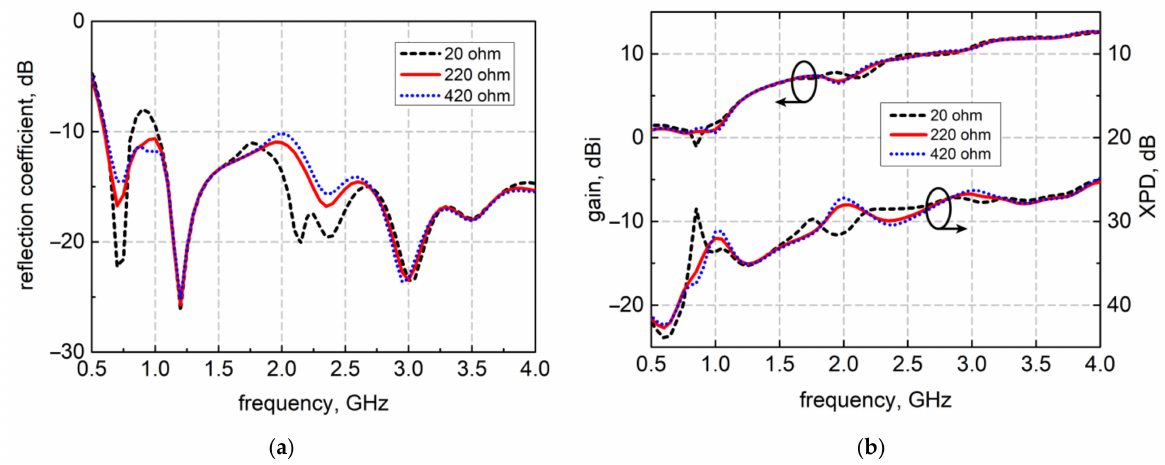
Figure 4. Performance comparison of Dual-loop DSATSA at different resistance values. ( a ) The reflection coefficient ( S 11 ); ( b ) the co-polarized gain and XPD at boresight.